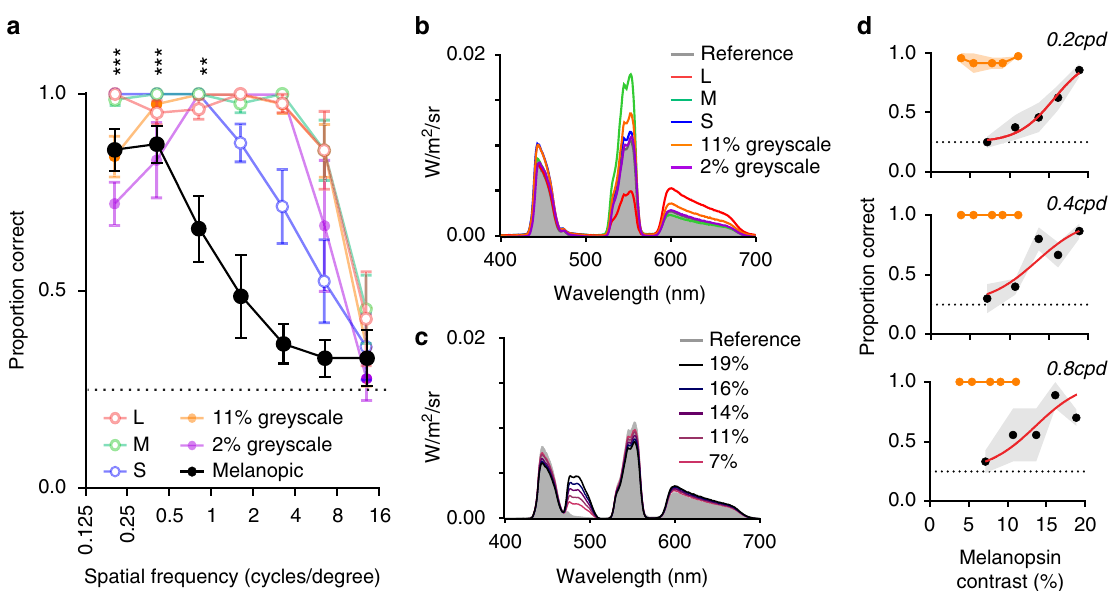
Fig. 2 Spatial frequency tuning of melanopsin form vision. a Proportion of correctly identi fi ed stimuli at spatial frequencies between 0.2 and 12.8 cycles per degree (cpd), individually calibrated ‘ melanopic ’ stimuli (black) and stimuli designed to target cone photoreceptors (11% L, M or S, 11% greyscale, 2% greyscale, represented by red, green, blue, orange and purple points, respectively). Repeated measures one-way ANOVAs showed signi fi cant effect of spatial frequency for all sets of stimuli ( p < 0.001). The proportion of correct responses at each spatial frequency was compared with chance (0.25) using a one-sample t -test. For melanopic stimuli: ** p < 0.01; *** p < 0.001. Data show mean ± SEM; n = 7. Where no error bars are plotted, all participants were correct in 100% of trials. b Spectral power distributions of stimuli targeting cone photoreceptors. Grey shaded spectrum: background spectrum (common to all spectral pairs); coloured lines show the other element of a stimulus pair used to form gratings at 11% L, M or S Michelson contrast, 11% greyscale, 2% greyscale (red, green, blue, orange and purple points, respectively). c Spectral power distributions of stimuli targeting melanopsin at a range of contrasts (stimuli as calibrated for one participant). Grey shaded spectrum: background spectrum (common to all spectral pairs); coloured lines shows spectra used to present 7 – 19% melanopsin contrast. d Contrast response functions for melanopic (black) and greyscale stimuli (orange) for 0.2, 0.4 and 0.8 cpd stimuli. Grey shading shows SEM. Sigmoidal dose – response curves were fi tted to data (red lines)